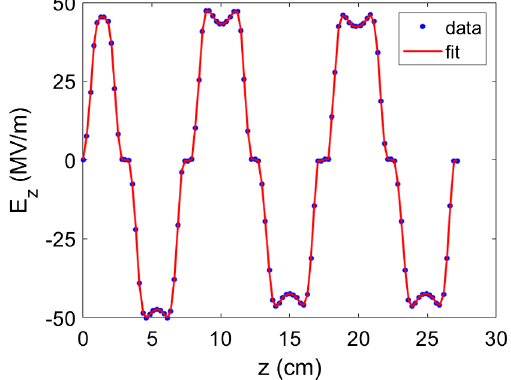
FIG. 1. Longitudinal E-field profile of linac from Ref. [29].